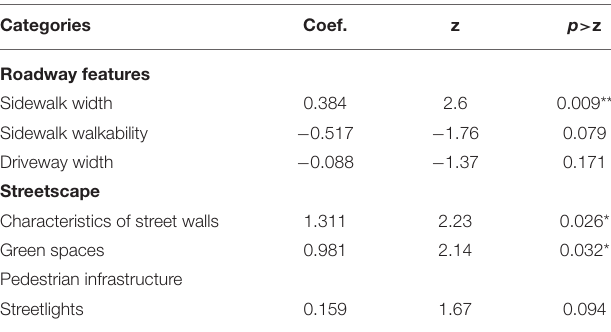
TABLE 4 | Conditional logit results of chosen and shortest route (the part-route which deviated from the alternative route). Categories Coef.